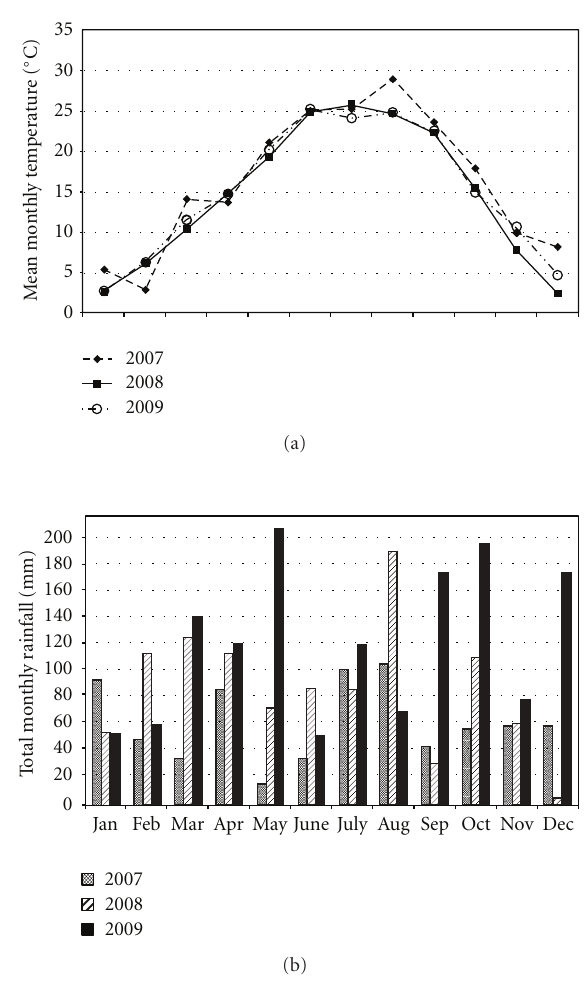
Figure 1: Monthly rainfall totals and mean monthly temperatures at study site, Hazel Green,